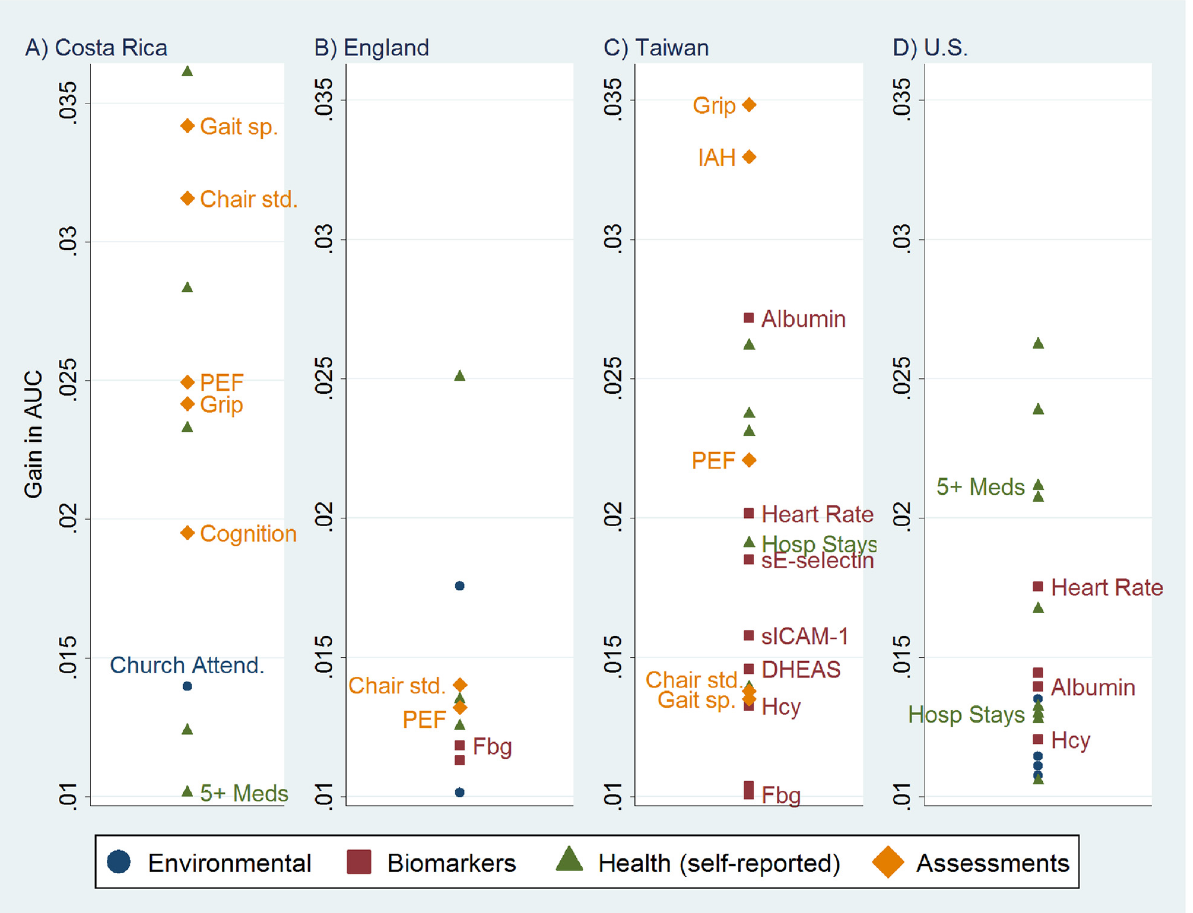
Fig 3. Additional Predictors of Five-Year Mortality that Yield a Gain in AUC (cid:1) 0.01 After Adjustment for Age and Sex, A) Costa Rica, B) England, C) Taiwan, and D) the U.S. The unlabeled markers represent variables displayed in Fig 1. Abbreviations: 5+ Meds, 5 + Medications; AUC, Area under the receiver operating characteristic curve; Chair std., Chair stand speed; Church Attend., Church attendance; Fbg, Fibrinogen; Gait sp., Gait Speed; Grip, Grip strength; Hcy, Homocysteine; Hosp stays, Number of hospitalizations; IAH, Interviewer-assessed health status; IL-6, Interleukin-6; PEF, Peak expiratory flow; sE-selectin, Soluble E-selectin; sICAM-1, Soluble intercellular adhesion molecule